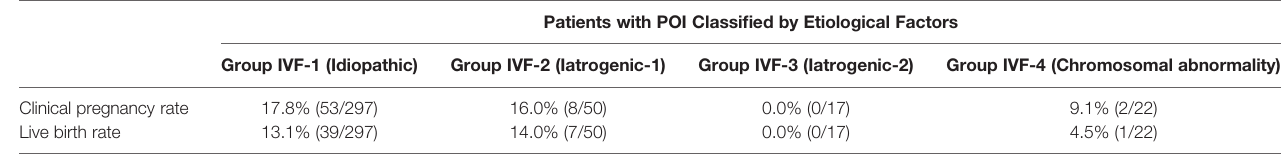
TABLE 5 | Clinical pregnancy and live birth rates per case in patients in Group IVF categorized into four groups by possible etiological factors.